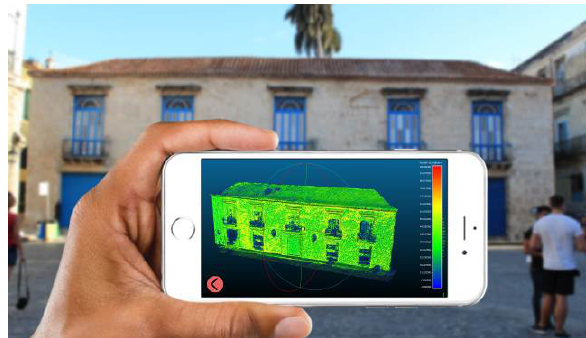
Figure 14. Example of a digital mockup